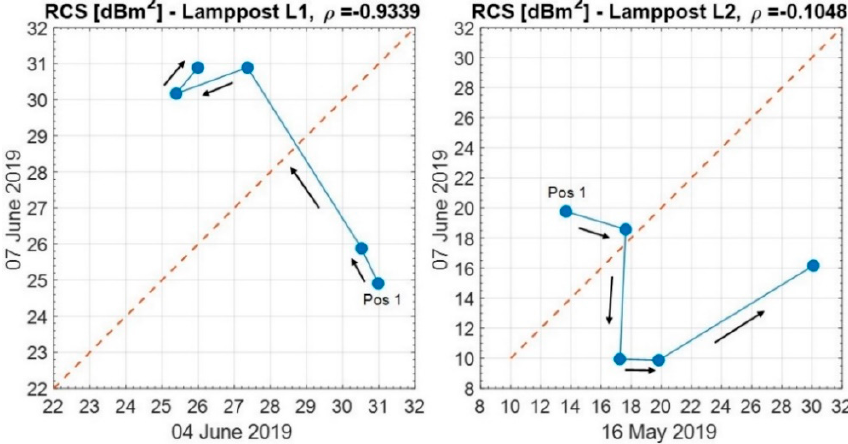
Figure 15. Comparison of the measured RCS of lampposts L1 and L2 on different days, varying the antenna position. Starting from the maximum antenna elevation (Position 1), the arrows denote the successive positions of the antenna up to the minimum antenna elevation.